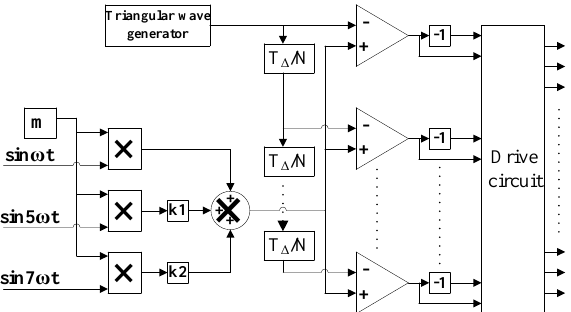
Figure 7. Schematic diagram of phase-shifted control pulse generation.